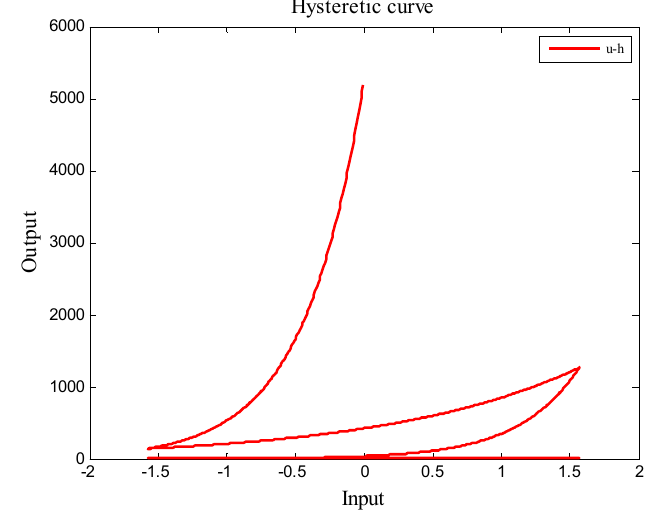
Figure 7. An unstable Bouc–Wen model for the piezoelectric materials.